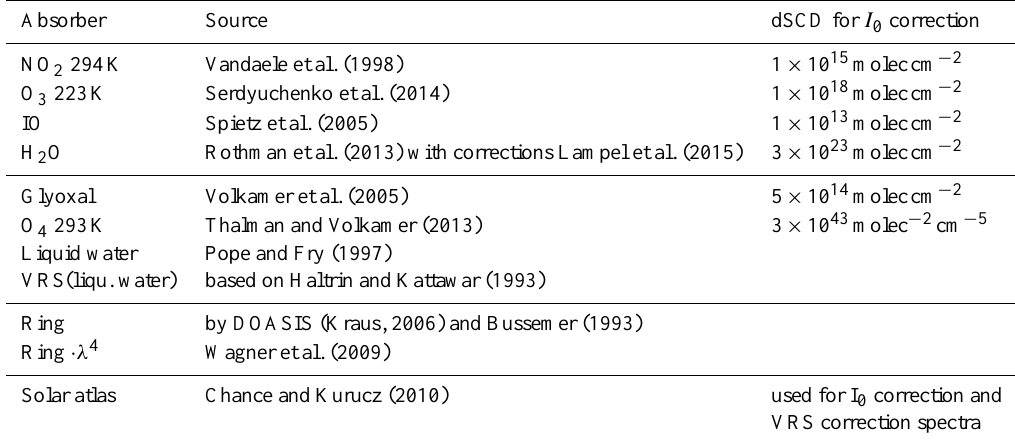
Table 6. Cross-sections used for the spectral (DOAS) retrieval. All shift and squeeze parameters of the cross-sections were linked, those of Ring and reference spectrum were linked separately. The retrieval interval settings for each used trace gas are given in Table 8.